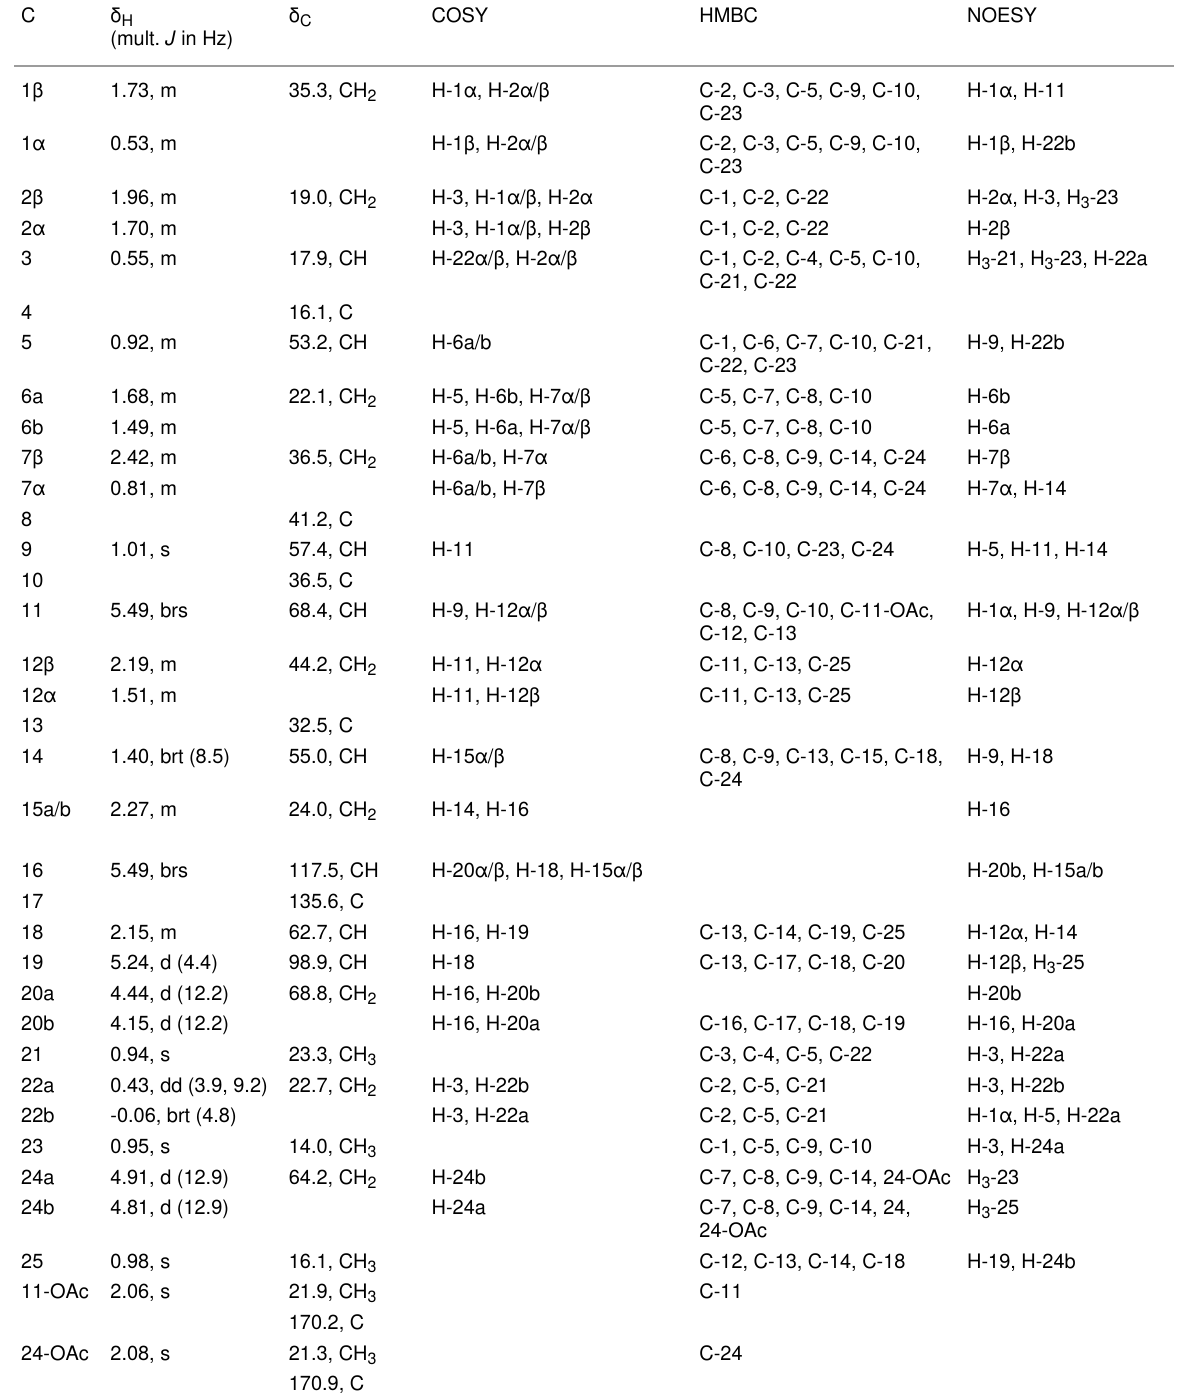
Table 1: NMR spectroscopic data of 12-deacetoxy-4-demethyl-11,24-diacetoxy-3,4-methylenedeoxoscalarin (CDCl 3